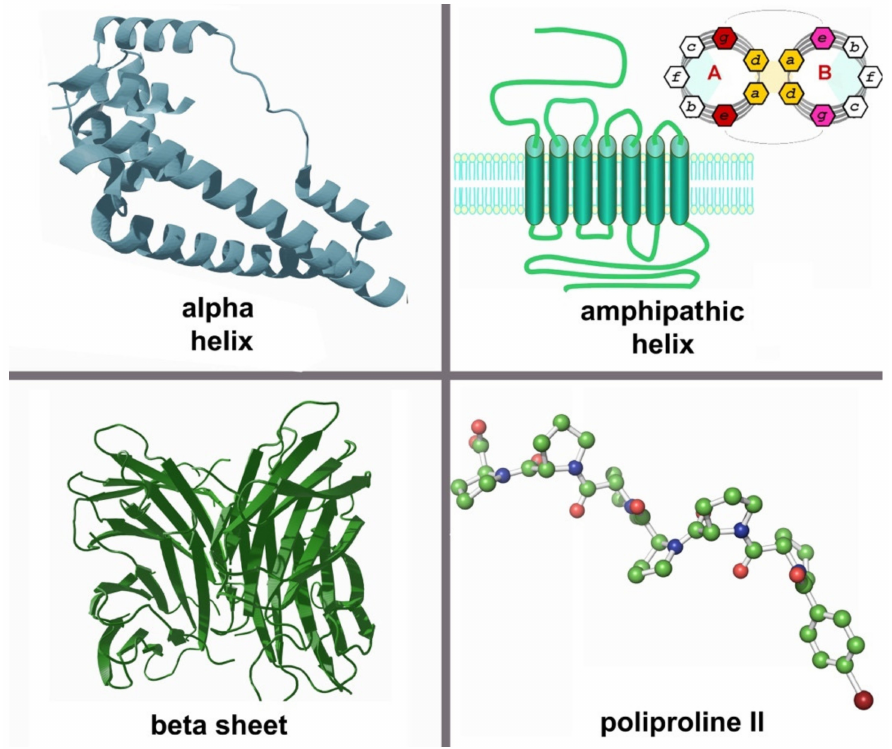
Figure 1. Secondary structures: α -helix (Protein data bank code: pdb1YG2); amphipathic he- lix (adapted by [90] and [91]); β -sheets (pdb5MAZ); polyproline II structure assumed by N-(4- Bromobenzoyl)hexaproline acetonitrile solvate